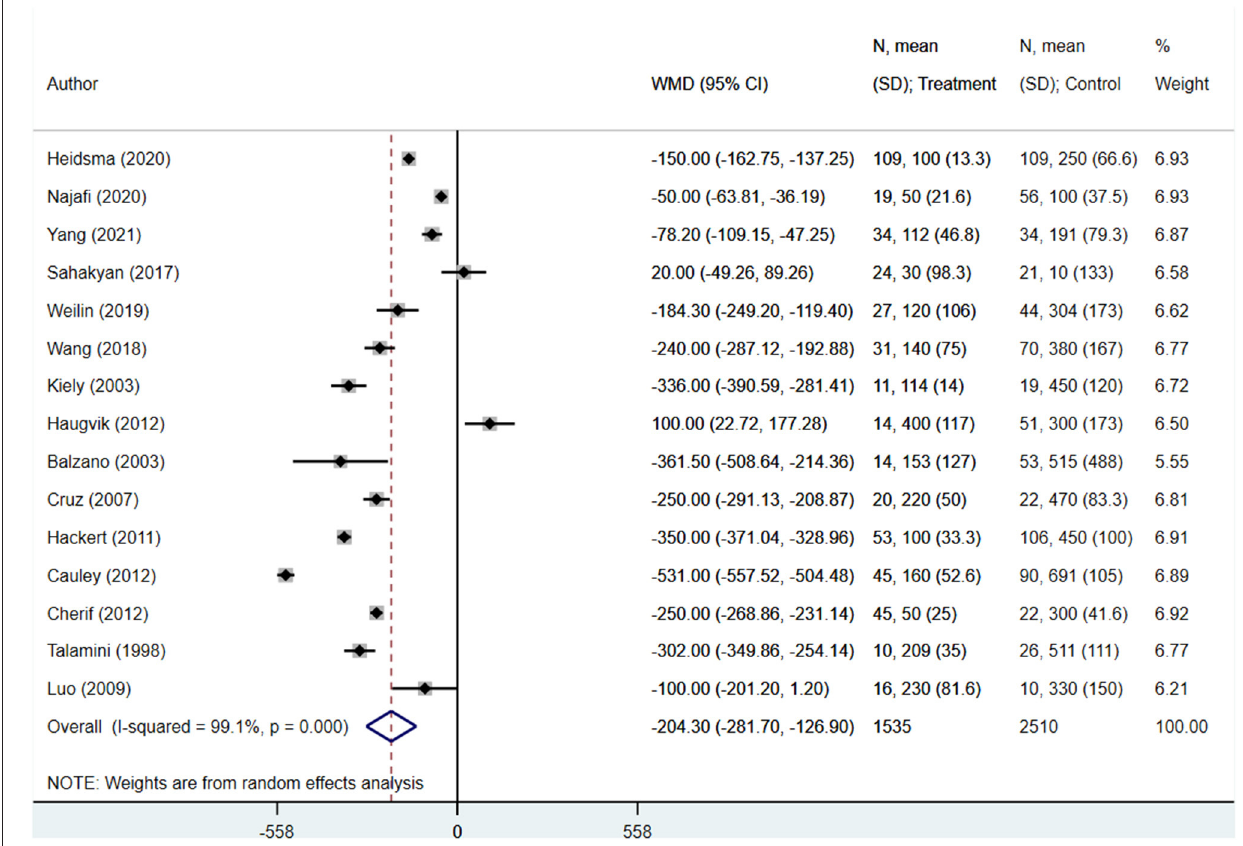
FIGURE 3 | Comparison of blood loss (in ml) between enucleation and standard surgical resection.